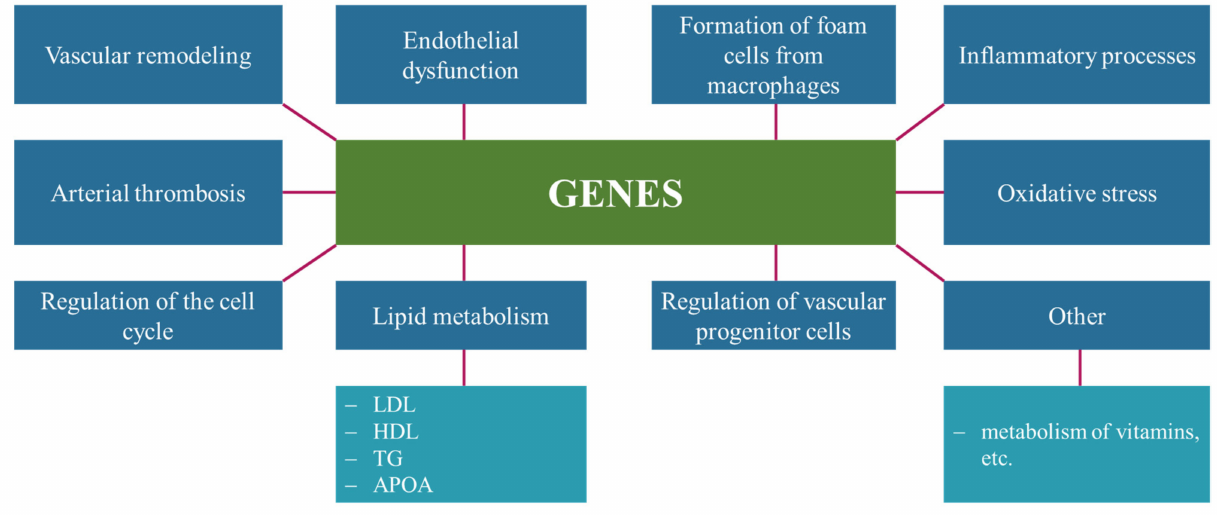
Figure 6. Genes affecting the development of